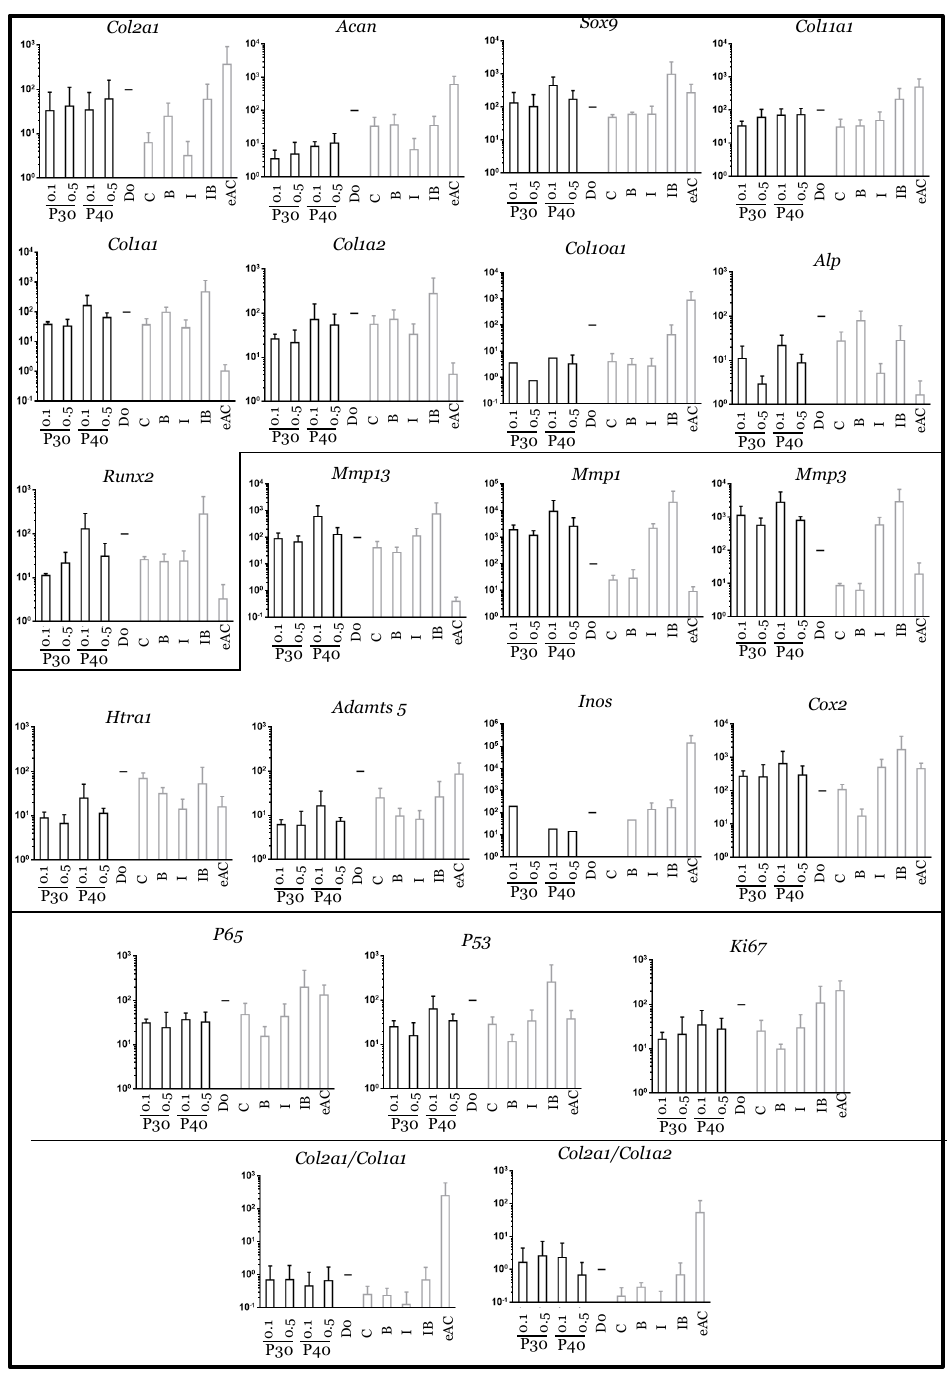
Figure 9. mRNA expression in equine articular chondrocytes treated with Promerim ® 30 and 40 used at low concentrations in the presence of IL-1. Equine articular chondrocytes were grown in type I/III collagen sponges at the third passage (P3). They were incubated for 7 days under hypoxia in the absence (C: control) or both the presence of IL-1 + P30 and IL-1 + P40, or BMP-2 alone (B), or IL-1 alone (I), or BMP-2 together with IL-1 (IB). The Promerim ® were used at the concentrations of 0.1 and 0.5 µg/mL. The mRNAs were estimated using RT-qPCR after normalization with respect to the β -actin reference gene. Transcript expression is shown in arbitrary units. The Col2a1 : Col1a1 and Col2a1 : Col1a2 ratios are given. The results are shown as histograms and the significance of the values between the different treatments and the control case (IL-1) was tested using a Mann–Whitney test; n = 3. eAC: mRNA extracts obtained from equine articular chondrocytes released from cartilage after overnight enzymatic digestion were used as controls. D0: cells seeded in sponges and arrested after 16 h of incubation. P30 and P40: Promerim ® 30 and 40.